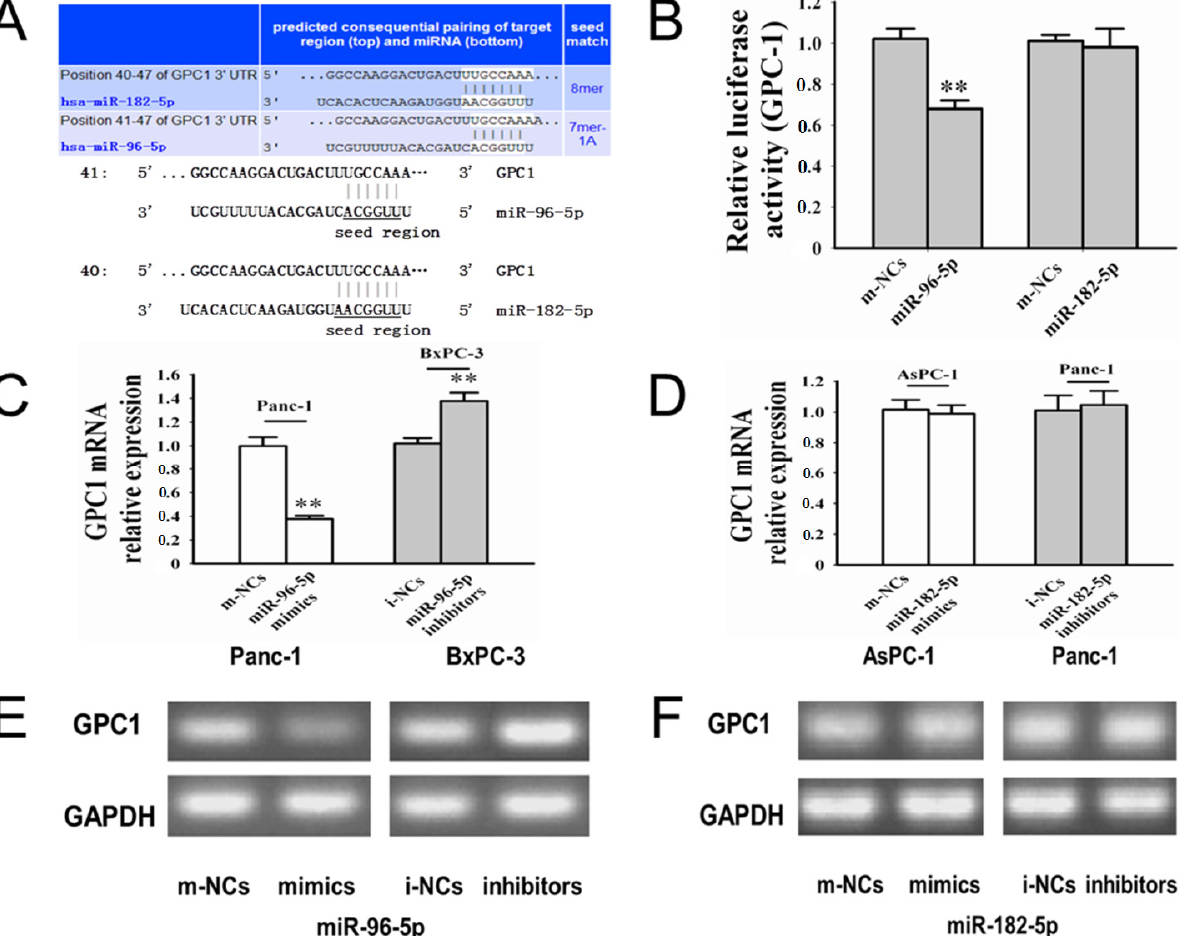
Figure 4. Effects of miR-96-5p and -182-5p on GPC1 expression. ( A ) The miR-96-5p and the miR-96-5p -binding site in the 3'-UTR of GPC1 . The miR-182-5p and the miR-182-5p -binding site in the 3'-UTR of GPC1 ; ( B ) Luciferase reporter assay with cotransfection of GPC1 3'-UTR and miR-96-5p , miR-182-5p , and their respective NCs in HEK-293T cells; ( C ) The expression level of GPC1 mRNA was down-regulated by miR-96-5p ; ( D ) The expression level of GPC1 mRNA was not significantly regulated by miR-182-5p using qRT-PCR; ( E ) Western blot results of GPC1 protein in Panc-1 and BxPC-3 transfected with miR-96-5p mimics, miR-96-5p inhibitors and their respective NCs at 48 h; ( F ) The expression level of GPC1 protein was not significantly regulated by miR-182-5p . All data from three separate experiments are presented as mean ± SD. ** p <